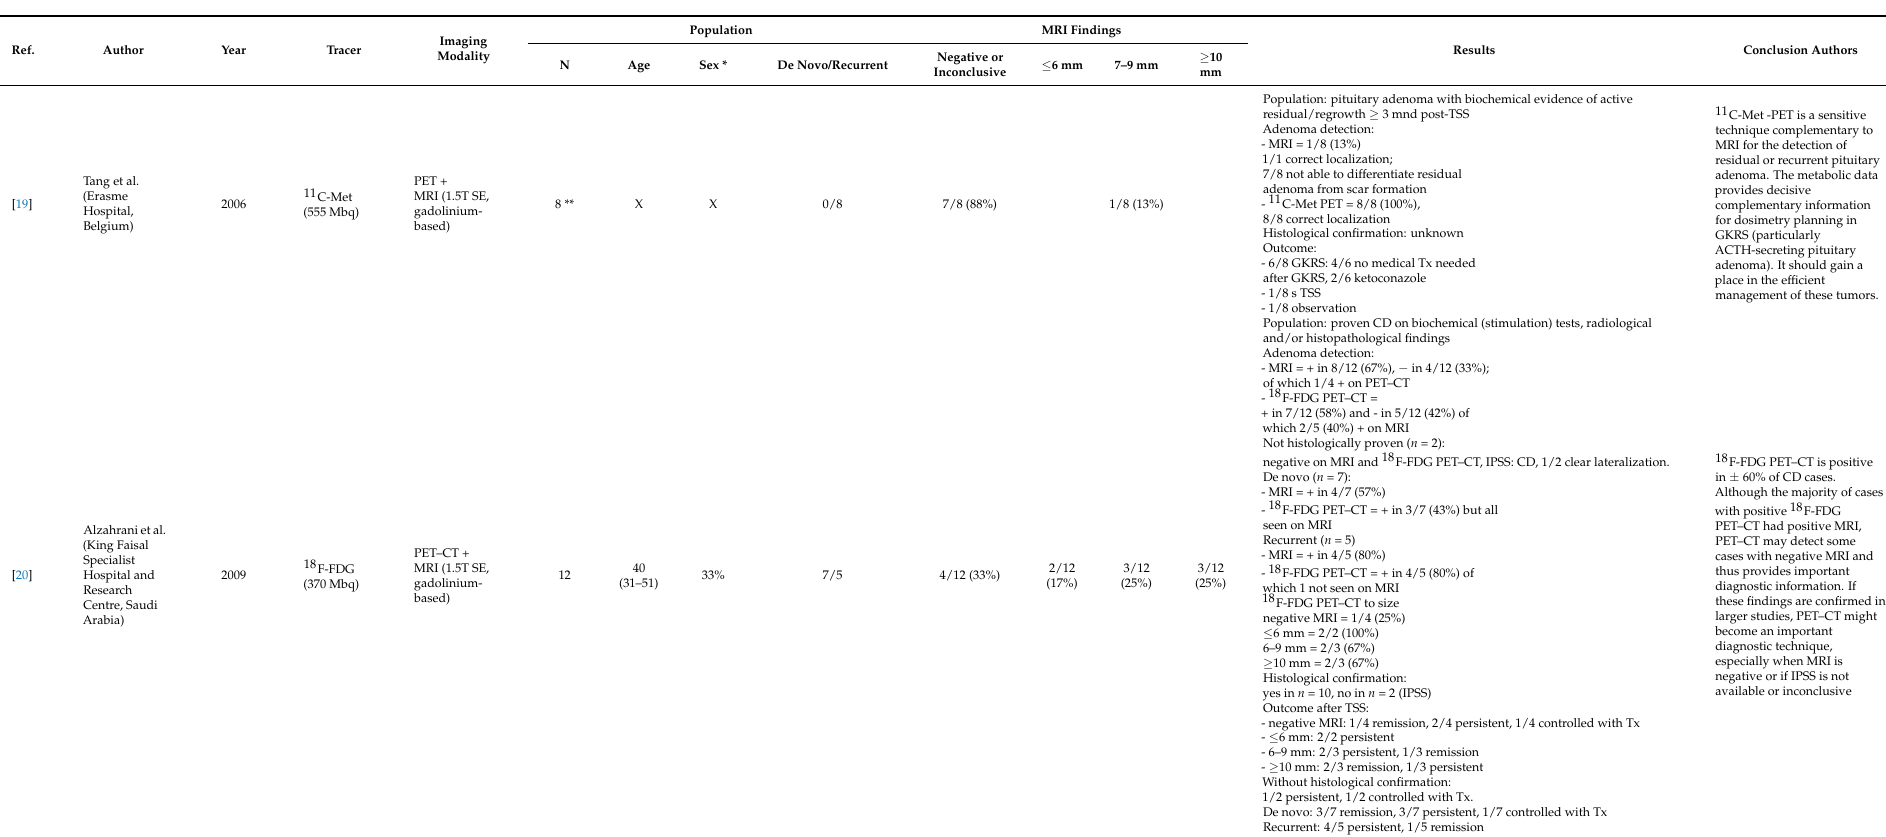
Table 1. Original studies on molecular imaging in Cushing’s